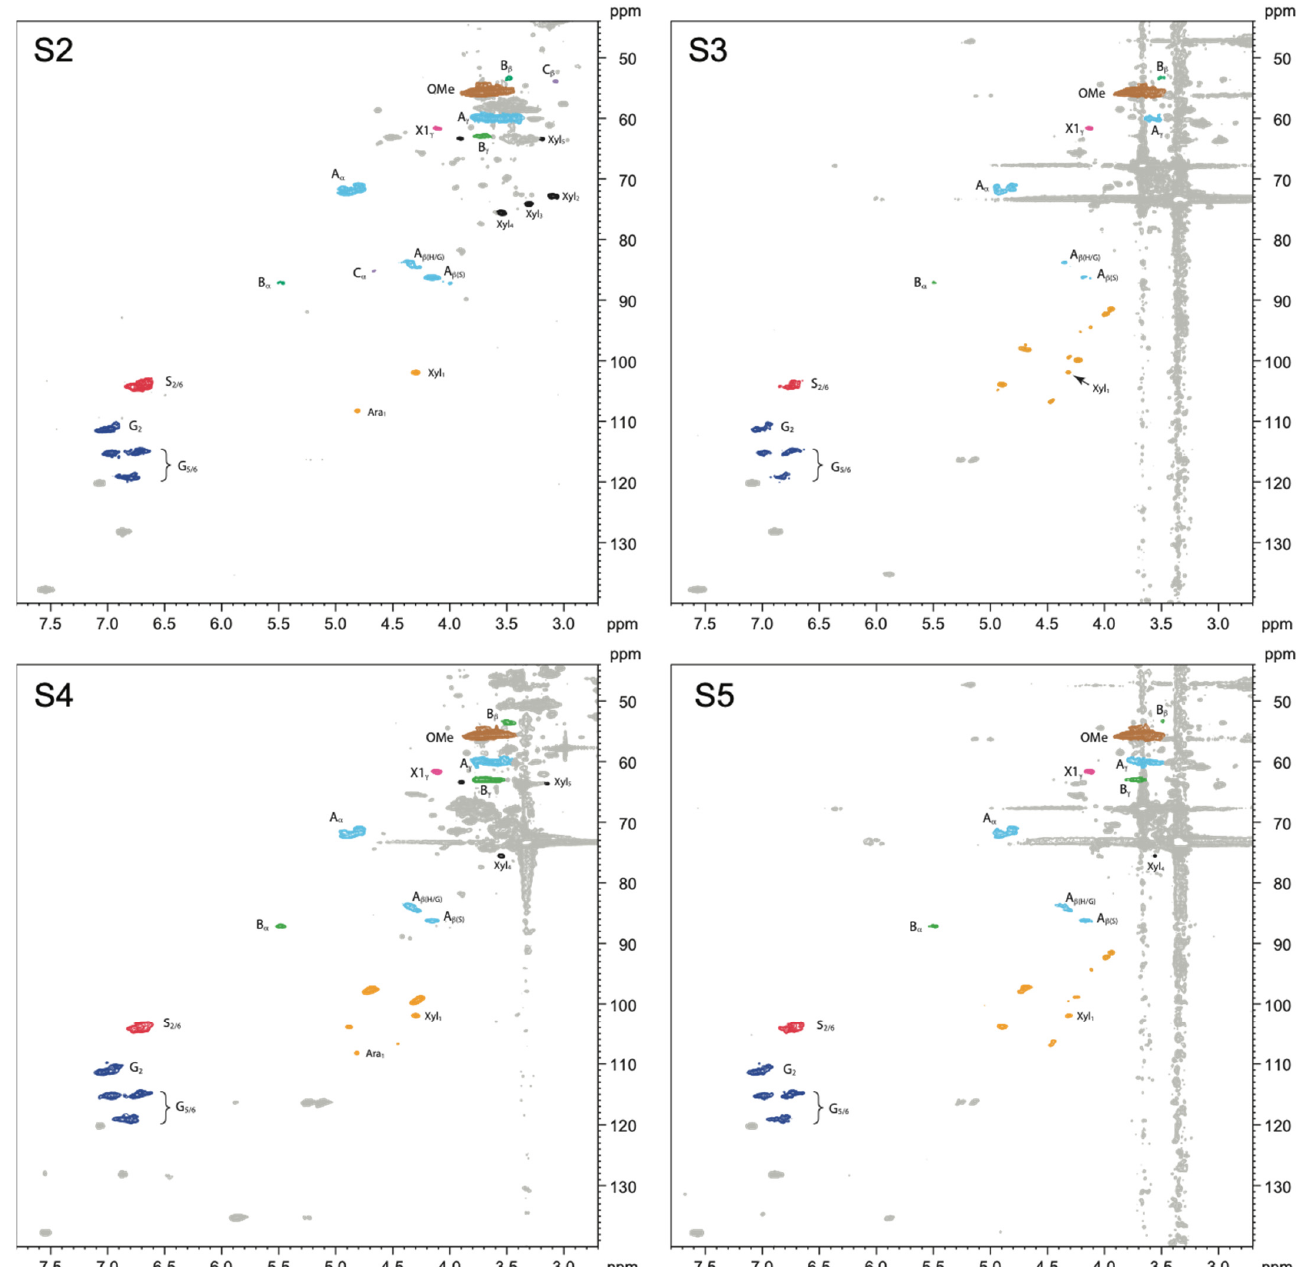
Figure 5. Partial 2D NMR spectra of siloxane-treated wood showing the effects of the treatment with (1,3-bis(3-aminopropyl)-1,1,3,3-tetramethyldisiloxane ( S2 ), 1,3-bis-[(diethylamino)-3-(propoxy)propan-2-ol]-1,1,3,3-tetramethyldisiloxane ( S3 ), 1,3-bis-[(ethylenodiamino)-3-(propoxy)propan-2-ol]-1,1,3,3-tetramethyldisiloxane ( S4 ), 1,3,5,7-tetrakis(1-(diethylamino)-3-(propoxy)propan-2-ol)-1,3,5,7-tetramethylcyclotetrasiloxane ( S5 ). The colored contours and labels correspond to the chemical structures shown in Figure